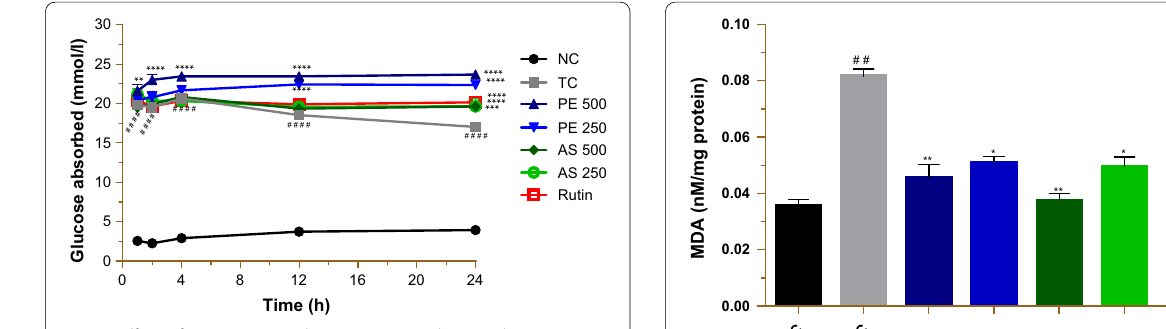
Fig. 5 Effect of P. erinaceus and A. spinosus on glucose absorption. NC normal control under 5 mM glucose; TC toxic control under = = 30 mM glucose; PE and AS 500; 250 P. erinaceus and A. spinosus Fig. 6 Effect of P. erinaceus and A. spinosus in MDA levels in kidney = at doses of 500 and 250 mg/kg bw 30 mM glucose; Rutin rutin fragments. NC normal control under 5 mM glucose; TC + = = at a dose of 500 µg/kg bw 30 mM glucose. The values were control under 30 mM glucose; PE and AS 500; 250 + analyzed with a two‑way ANOVA and then expressed as mean SEM. A. spinosus at doses of 500 and 250 mg/kg bw ± #### p < 0.0001 compared to NC; ** p < 0.05; *** p < 0.01; **** p < 0.0001; Rutin rutin at a dose of 500 µg/kg bw = compared to TC. n 5 values were analyzed with a one‑way ANOVA and then expressed = as mean SEM. ## p < 0.01 compared to NC; * p < 0.05; ** p < 0.01; ± compared to TC. n